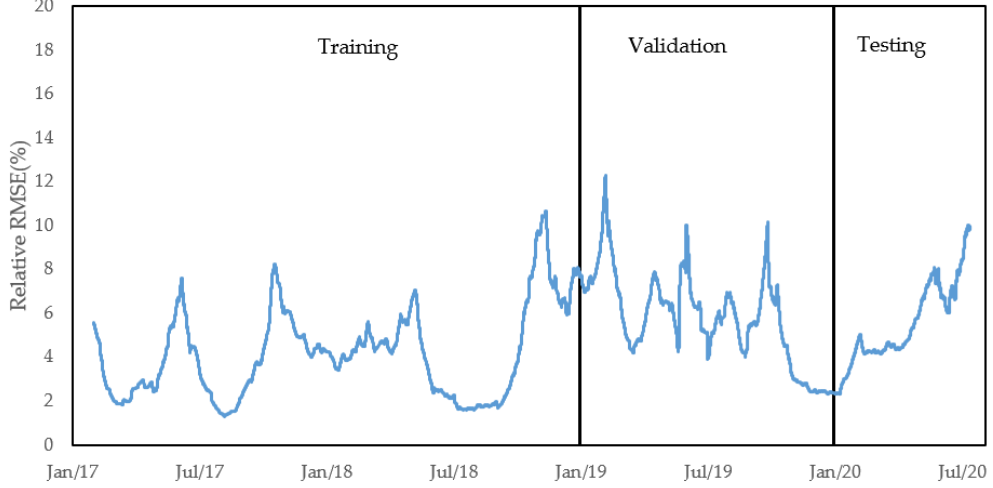
Figure 6. 30-day moving relative RMSE of the hybrid model.